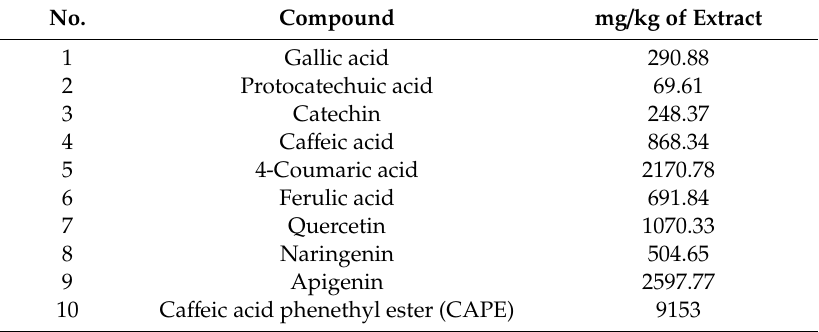
Table 1. Chemical composition of propolis extract identified by